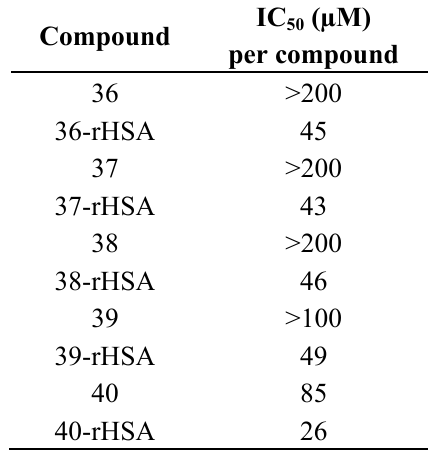
Table 3. IC of the different ruthenium-rHSA Conjugates 36 – 40 on A2780 human ovarian 50 cancer cells after 72 h